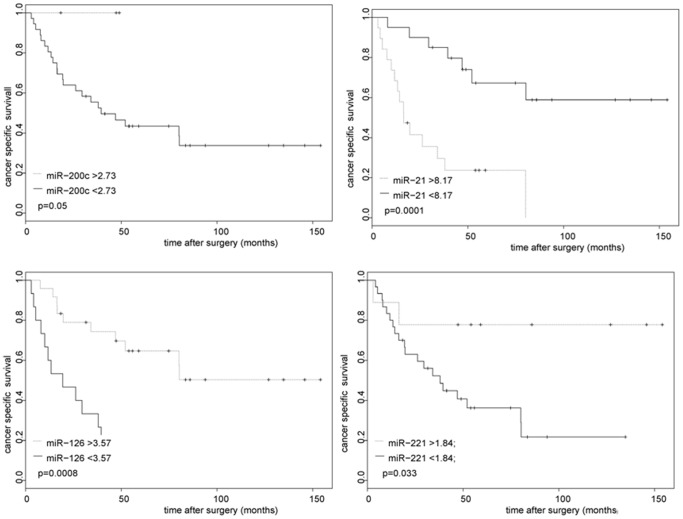
Kaplan Meier survival analysis for CSS in ccRCC/TT (n = 37) patients stratified by the dichotomized expression of miR- 200c, miR-21, mir-126 and miR-221.Risk scores (thresholds) for the miRs were determined by receiver operating characteristics (ROC) curves and indicated in the plots. The ccRCC/TT study cohort (n = 37) was stratified by the CRS of miR-21, miR-126 and miR-221. p values resulting from log rank tests are shown in the plots.